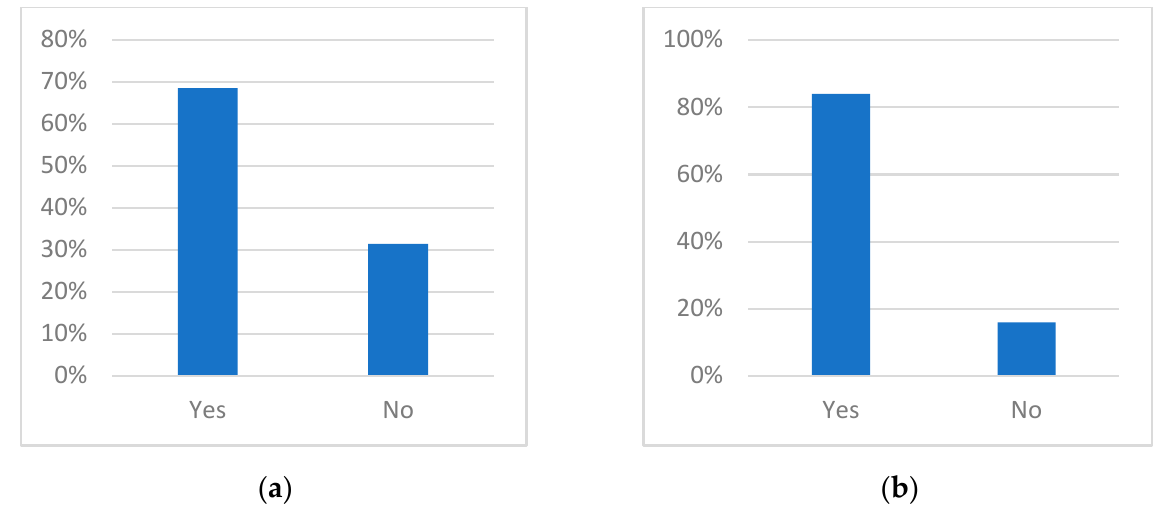
Figure 9. Has the COVID-19 pandemic affected the maritime cyber security landscape? ( a ) Europe; ( b ) Asia.